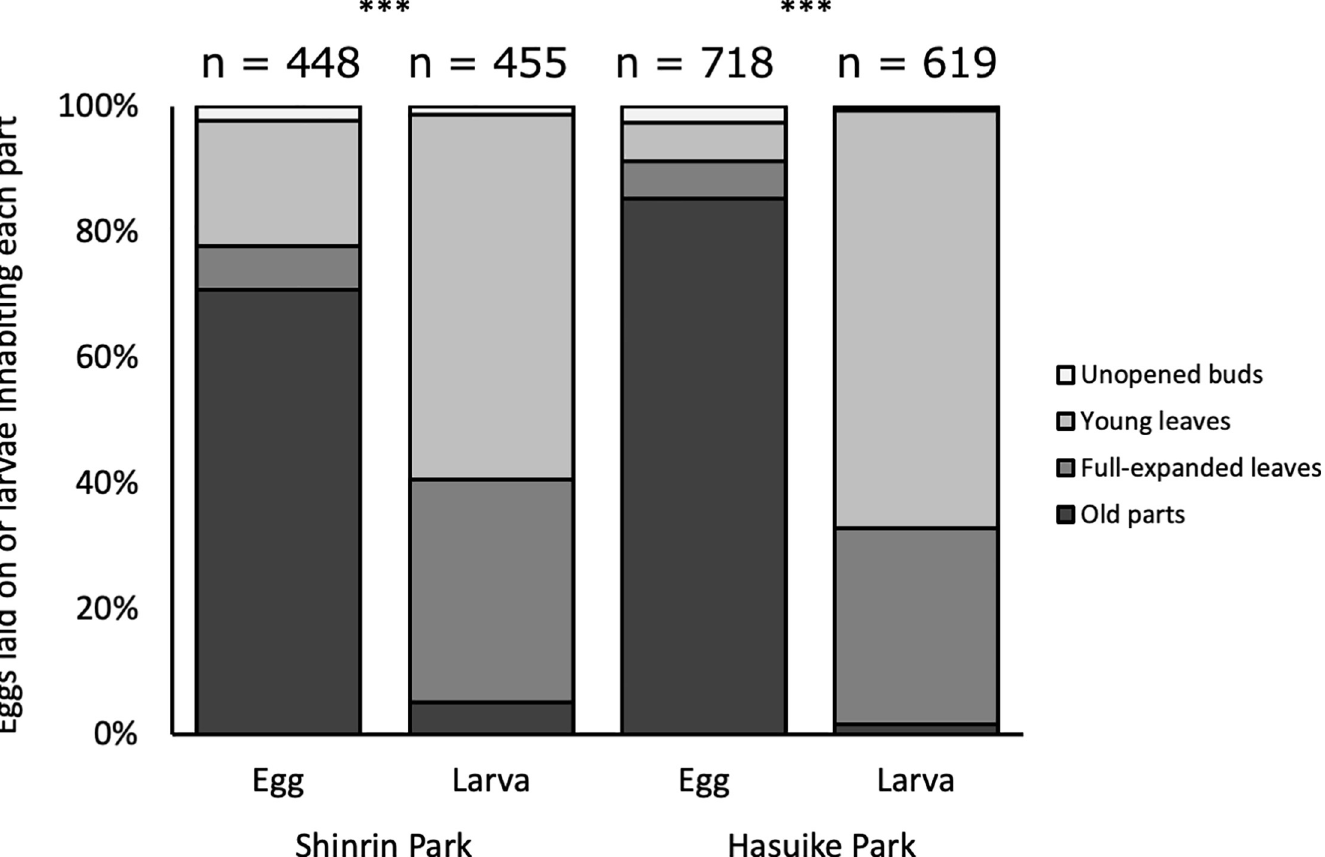
Fig 1. Oviposition and larval feeding sites of A . bazalus on L . edulis in Shinrin Park and Hasuike Park, Saga, Kyushu, Japan in